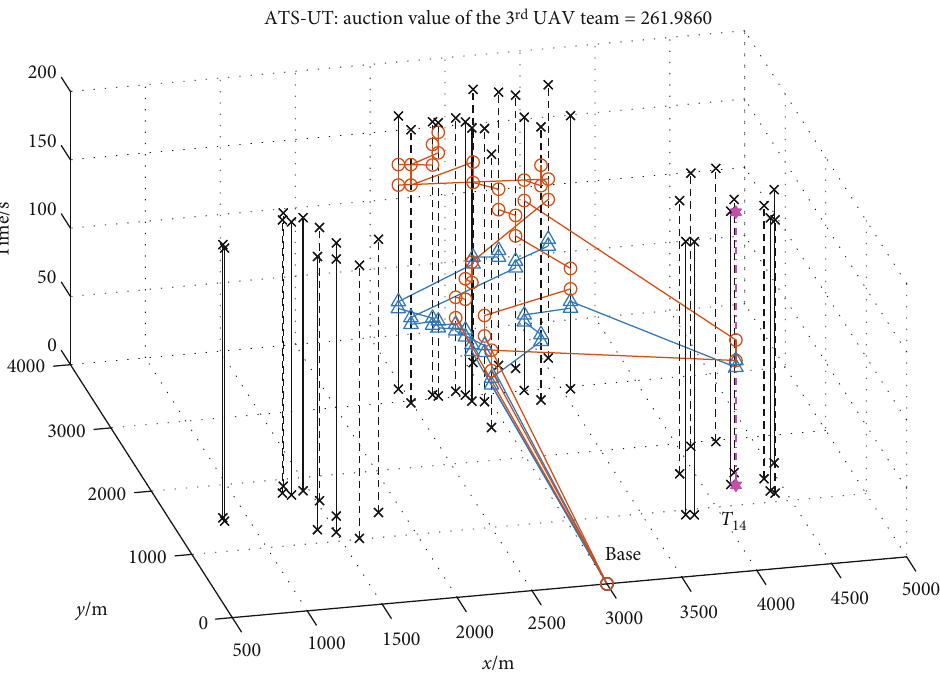
Figure 10: CBBA-PR auction information of the 3 rd UAV